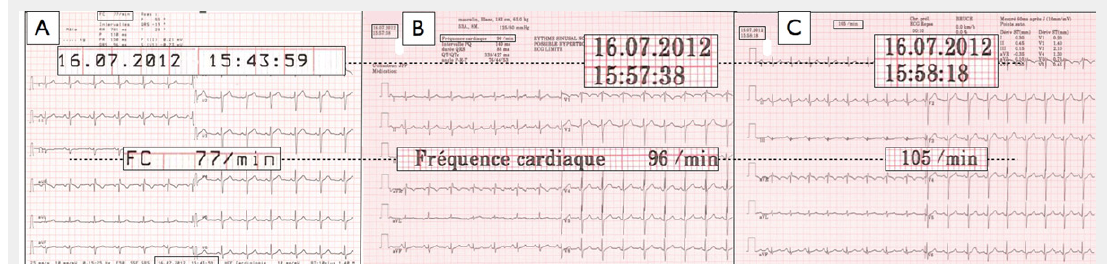
Example of the effect of mental stress due to exercise testing on “resting” heart rate. A 53 year old male with normal physical status was considered for exercise testing. His resting heart rate – as measured by a 30 seconds palpation the right radial pulse – was 72 beats per minute (bpm). Panel A depicts his “resting” 12-lead ECG recording made 15 minutes before initiation of exercise testing on a treadmill ergometer. Heart rate was 77 bpm. Panels B and C show his “baseline” ECGs as acquired on the treadmill ergometer 2 minutes (panel B), and 1 minute (panel C) before the test start. Heart rate was 96 bpm, and 105 bpm